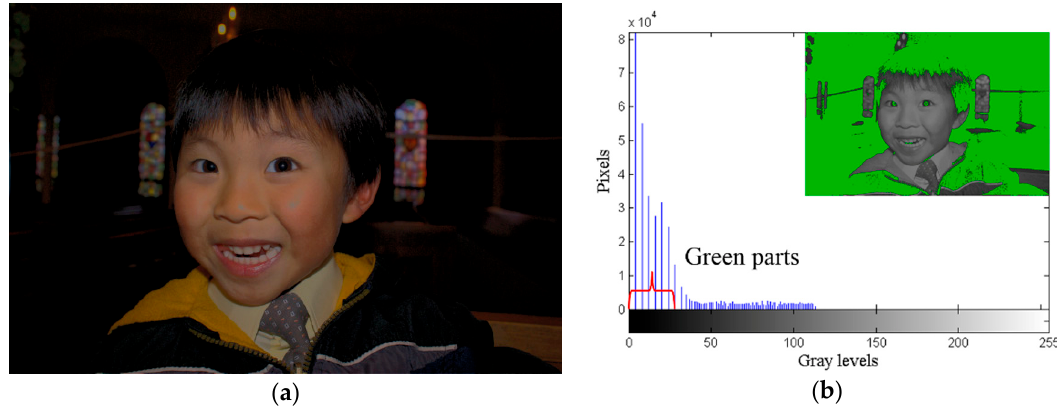
Figure 4. Daniel image, ( a ) GA image; ( b ) GA histogram.